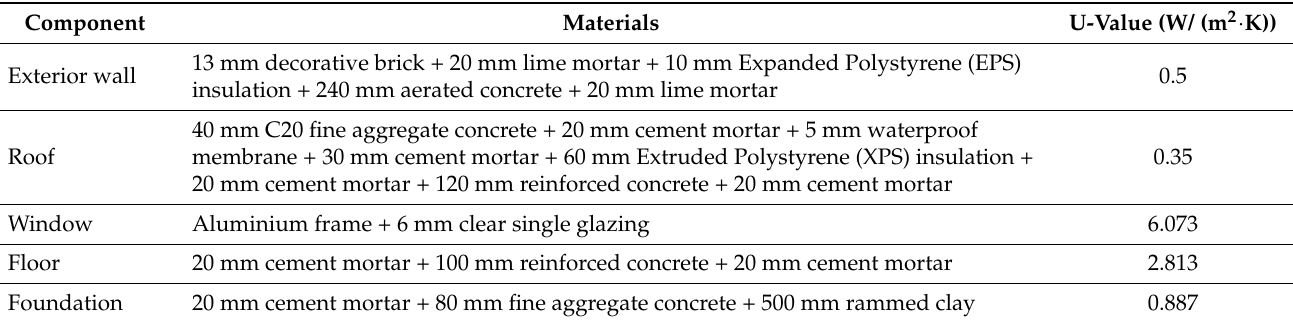
Table 3. Design parameter information of the building envelope.